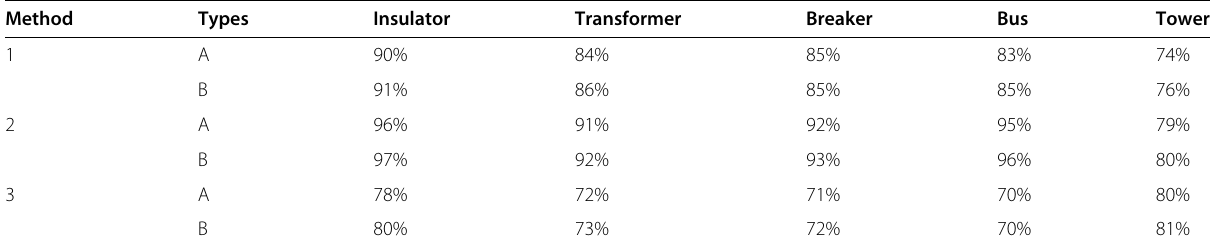
Table 3 Accuracy rates of the three methods for identification